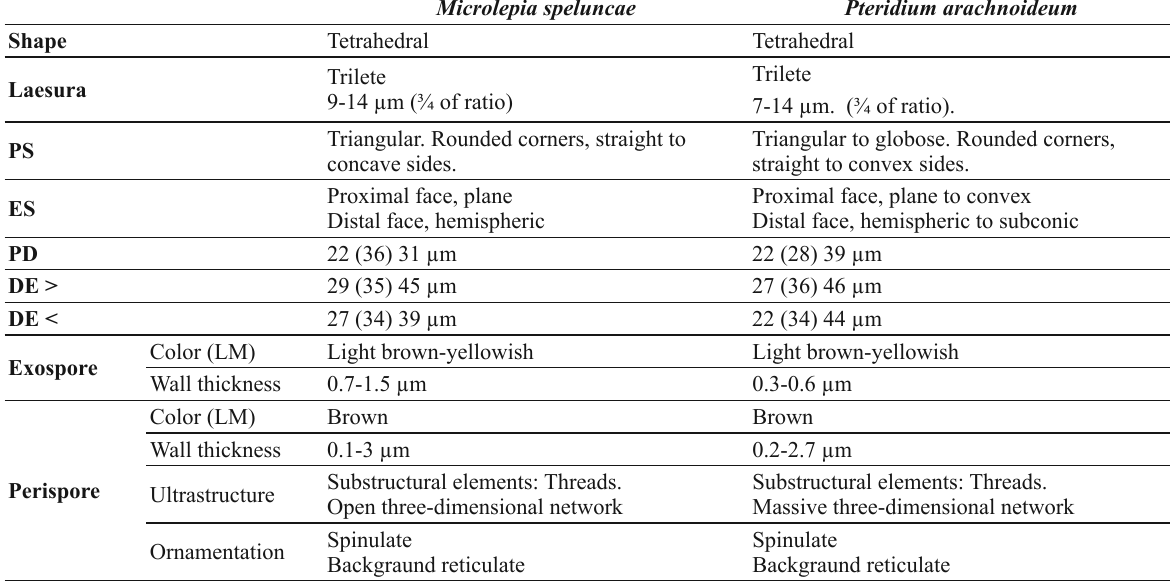
Characteristics of Micolepia speluncae and Pteridium arachnoideum